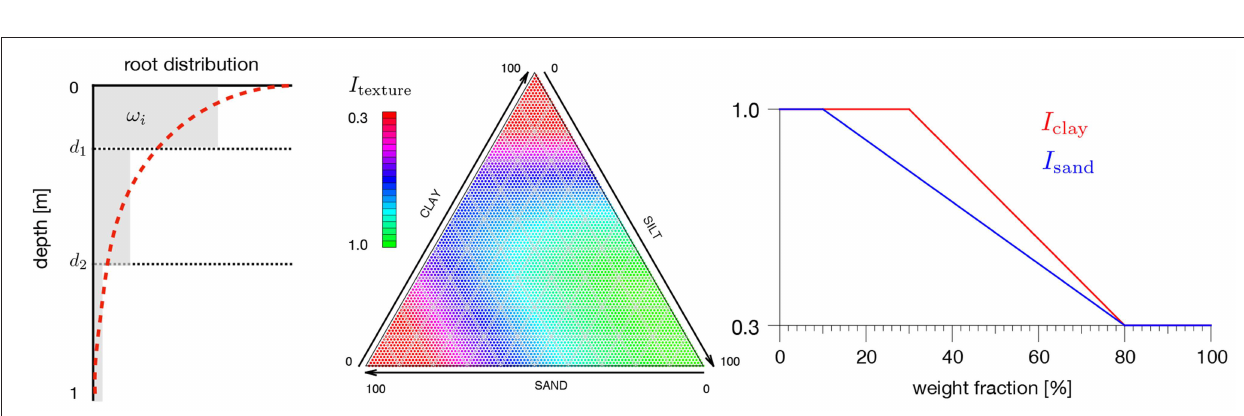
FIGURE 2 | Scoring functions for sand and clay content (Right) combined by their harmonic mean according to Equation (4) to get a dimensionless indicator for soil fertility based on soil texture (Middle, green is maximum) which is combined to an indicator for the entire soil profile by weighing the results for the different horizons based on the depth distribution of root length density (Left)